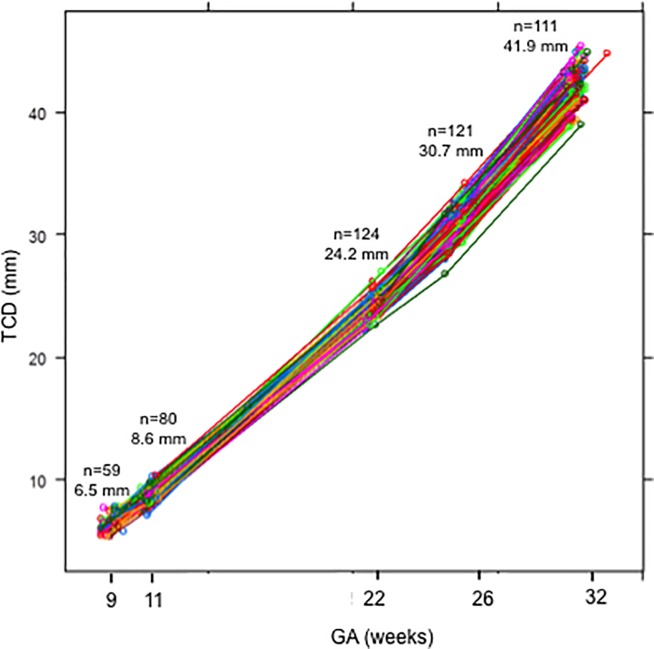
Longitudinal transcerebellar diameter (TCD, mm) measurements in the study population.Mean values at 9, 11, 22, 26 and 32 weeks of gestation are reported. Dots and lines represent TCD measurements and trajectories of a single included pregnancy. n: number; GA: gestational age.